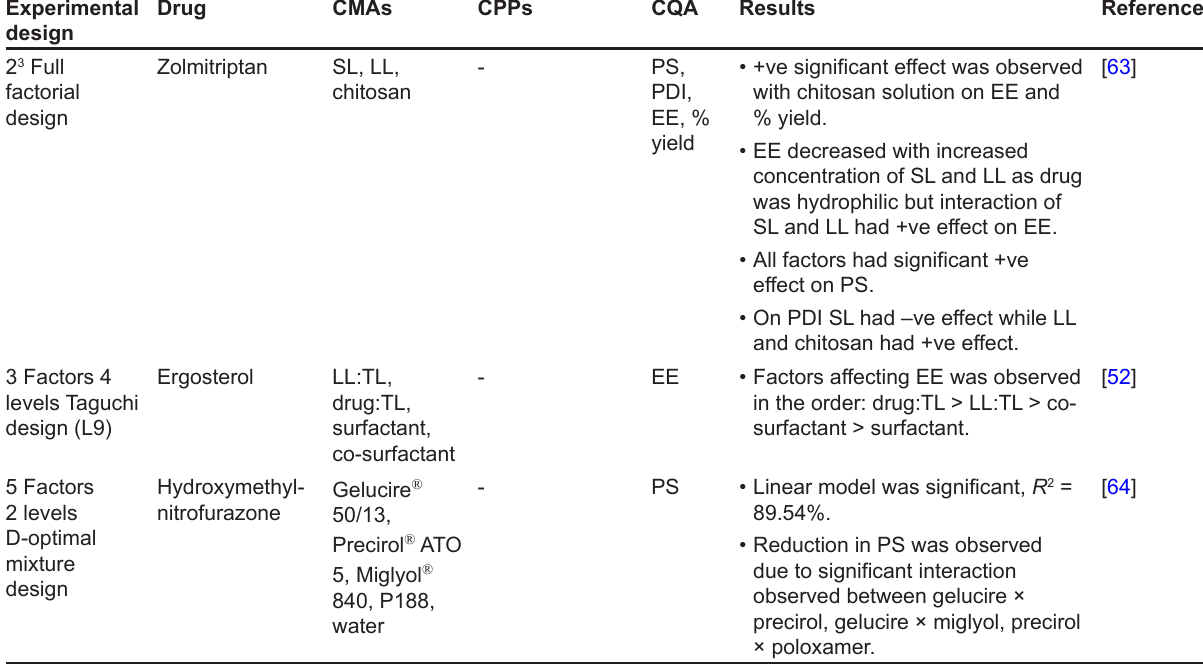
Table 4. Summary of optimization results by the application of QbD on NLC ( Continued )